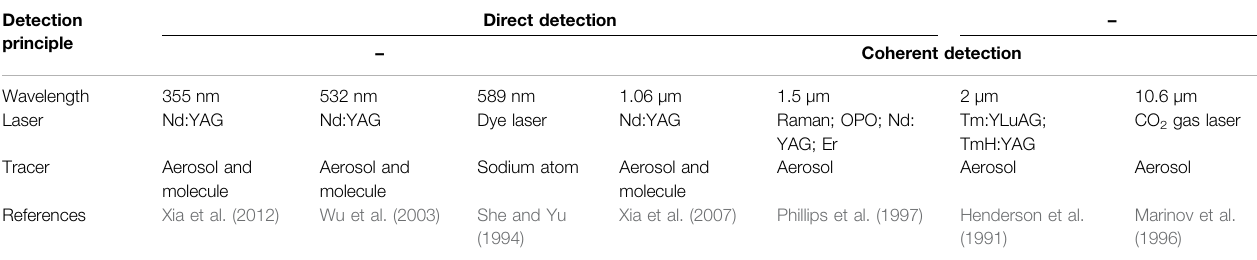
TABLE 1 | Differences in the selection of working wavelength between C-DWLs and D-DWLs. Detection